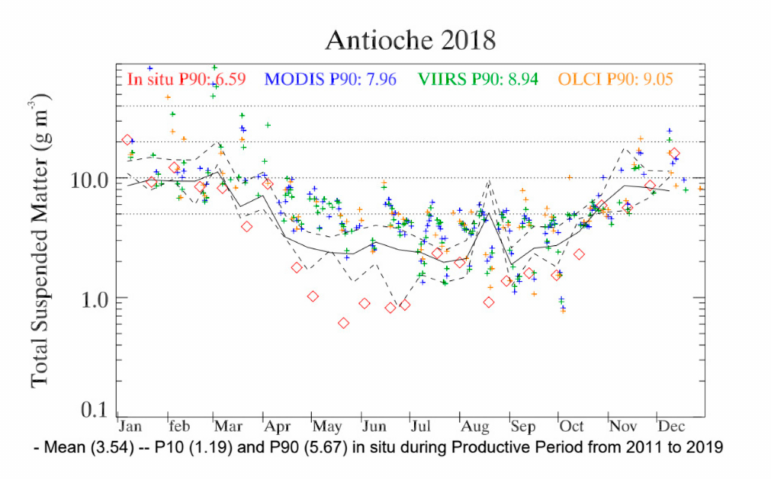
Figure 9. TSM at Antioche in 2018. In situ and satellite percentiles of year 2018 are indicated in the upper part of the graph; the in situ historical mean, P10 and P90, calculated over the productive period, are indicated under the time